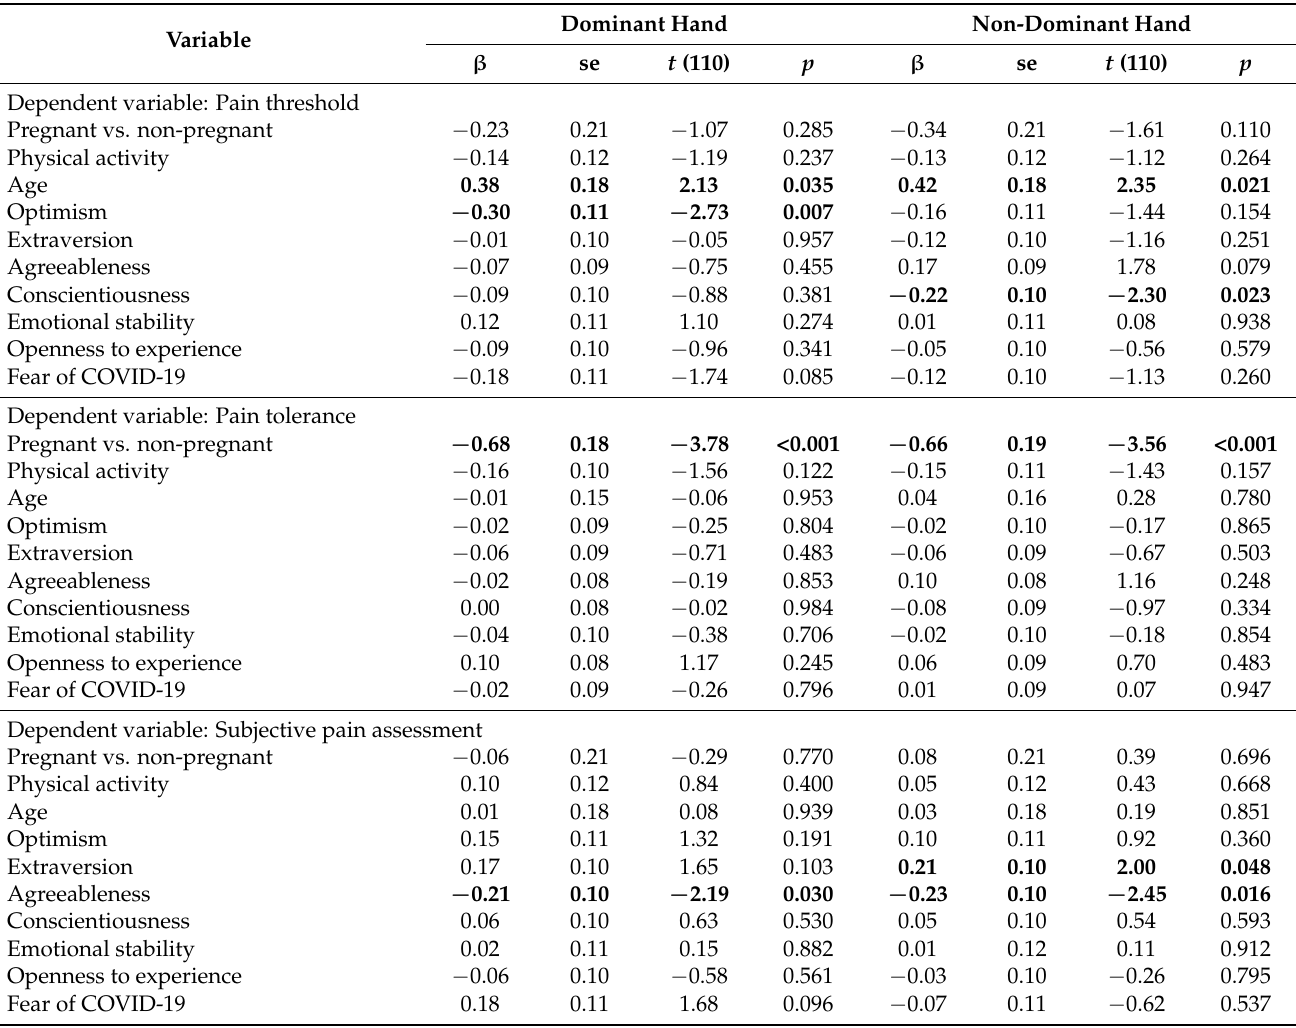
Table 4. General linear model for the predictors of pain sensitivity